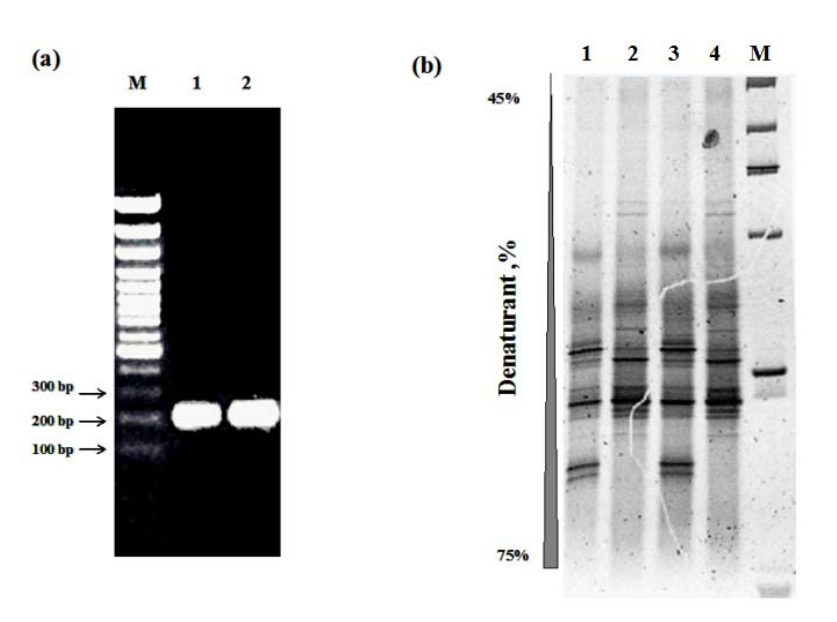
Figure 5. DGGE analysis of ATAD bacterial community DNA extracted by the two extraction procedures with amplification of the V3-V5 hypervariable region of 16S rRNA gene. (a) Non-denaturing gel electrophoresis of PCR products of the V3-V5 region amplified from ATAD DNA extracted by MoBIO commercial kit Lane (1) and solvent- based method Lane (2). M, 100 bp DNA ladder (5 μ l per lane). (b) DGGE (10% acrylamide, 30 to 80% denaturant) profile of the V3-V5 region amplified from MoBIO extracts (Lane 1 and 3), solvent based DNA extract (Lane 2 and 4), M, pBR 322/Alu I (1 μ g per